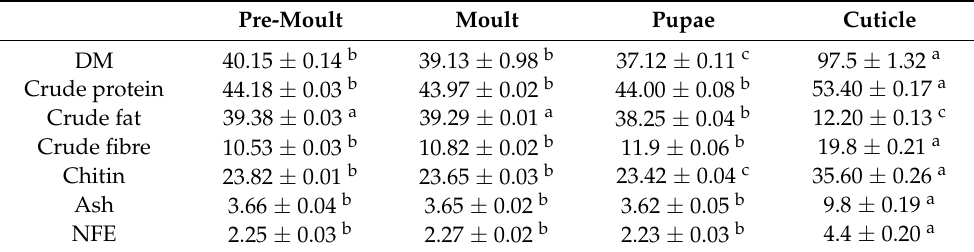
Table 8. Average nutrient compositions of YM at different development stages and average nutrient composition of the cuticle